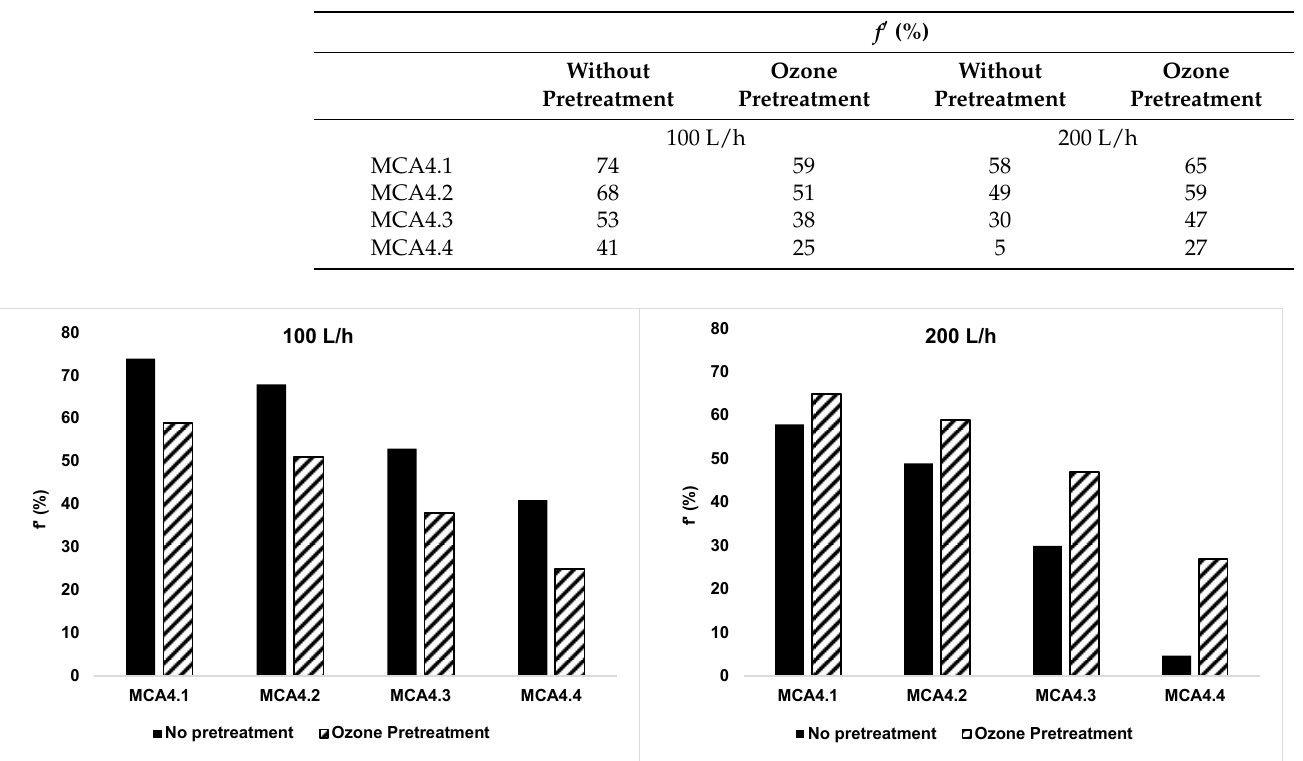
Figure 4. Representation of f ′ vs. membranes in pretreated and non-pretreated effluents for feed flowrates of 100 and 200 L/h. Table 4. Intrinsic rejection coefficient f’ for each membrane, feed flowrate, and with or without ozone pretreatment.